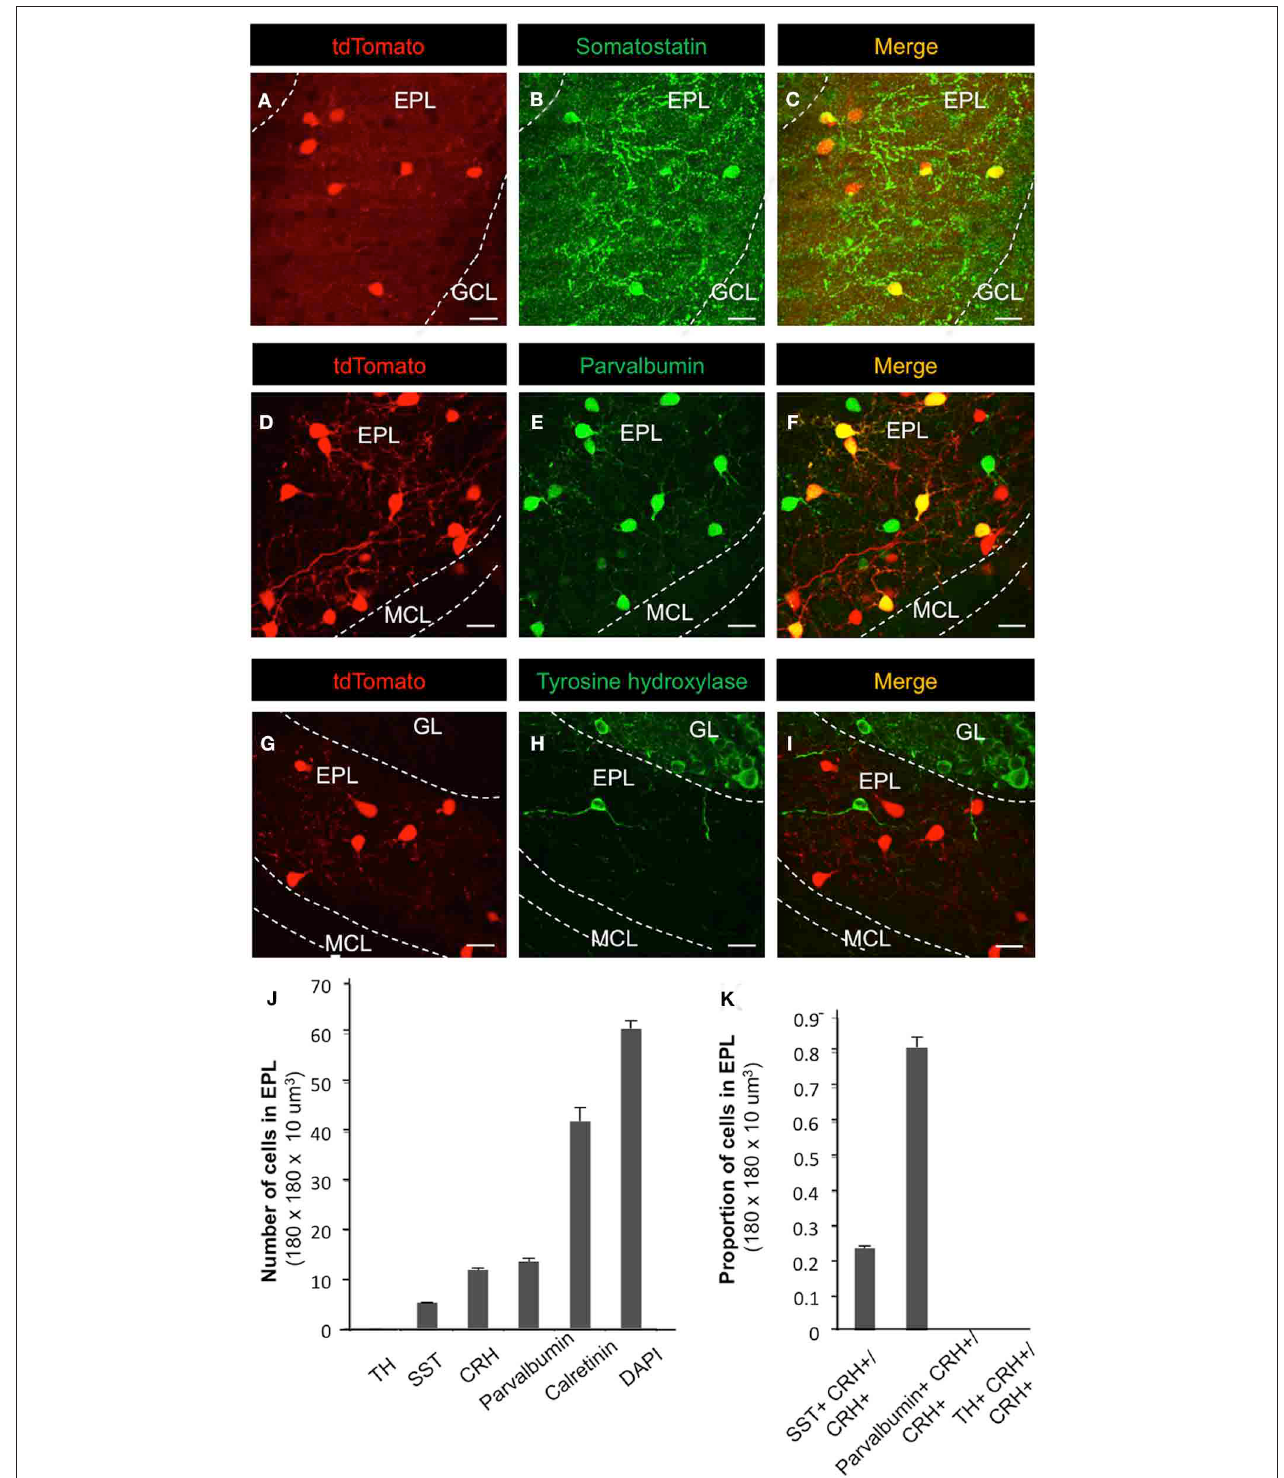
FIGURE 2 | Molecular marker expression in CRH + EPL interneurons. (A–I) Expression patterns of somatostatin, parvalbumin, and tyrosine hydroxylase in CRH-Cre; Rosa-lox-stop-lox-tdTomato mice. Scale bar, 20 μ m. (J) The number of cells that are labeled by tyrosine hydroxylase (TH), somatostatin (SST), CRH, parvalbumin, calretinin, and DAPI in EPL. N = 3 mice, and 20–30 sections each. (K) The fraction of CRH + neurons that are